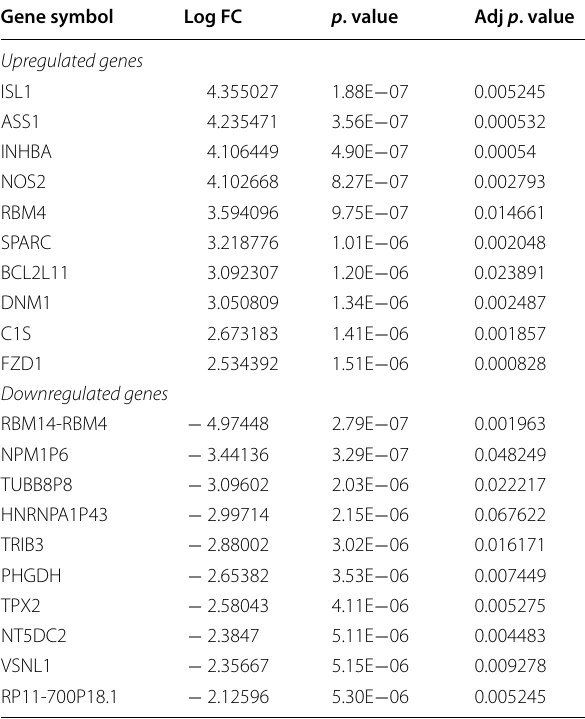
Table 1 Top 10 up- and downregulated genes in breast cancer stem